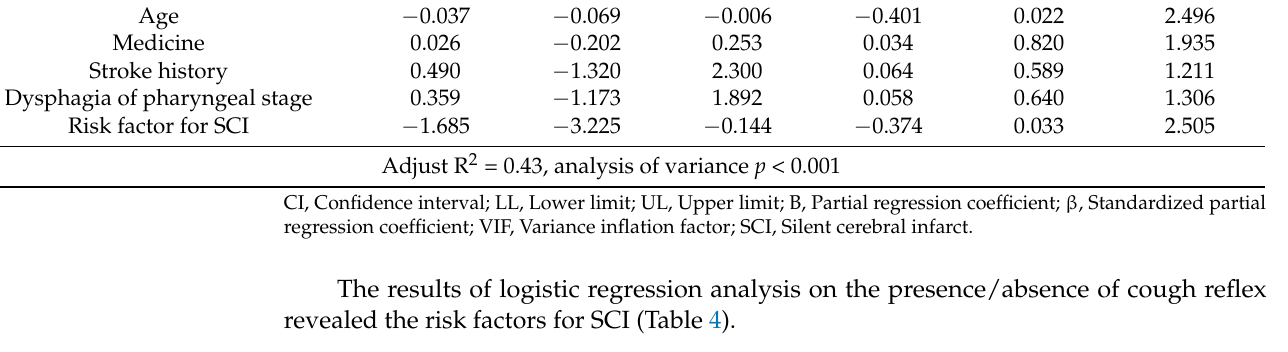
Table 4. Results of the logistic regression analysis for the presence or absence of cough ( n =